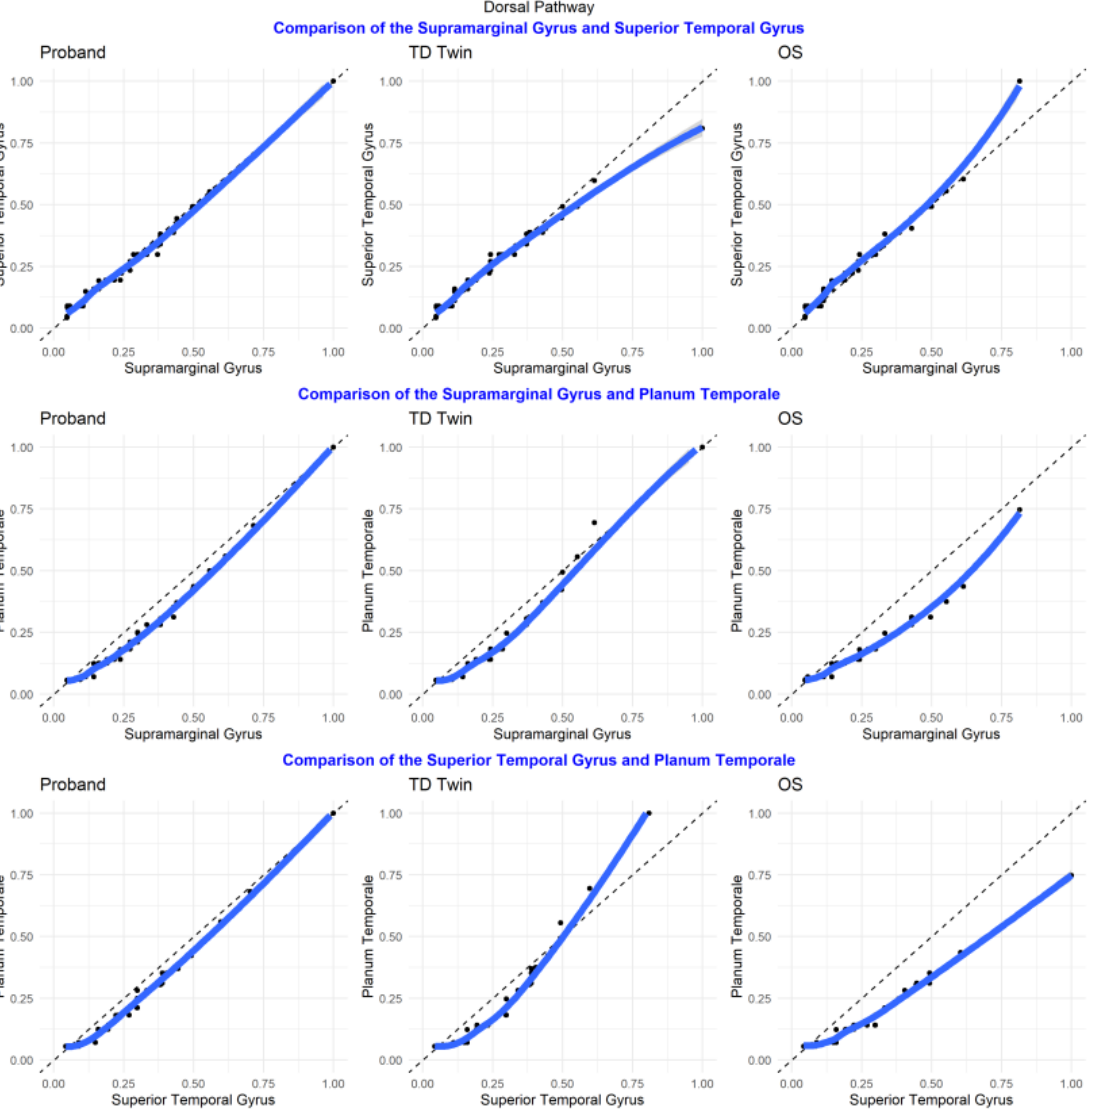
Figure 9. Select Q – Q plots of region of interest comparisons for regions in the dorsal pathway. Figure 9. Select Q–Q plots of region of interest comparisons for regions in the dorsal